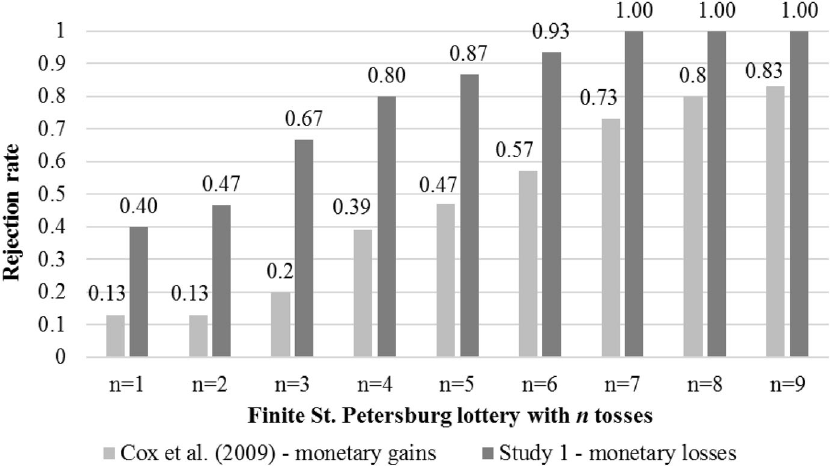
Fig. 1 Comparison of choices for positive or negative money